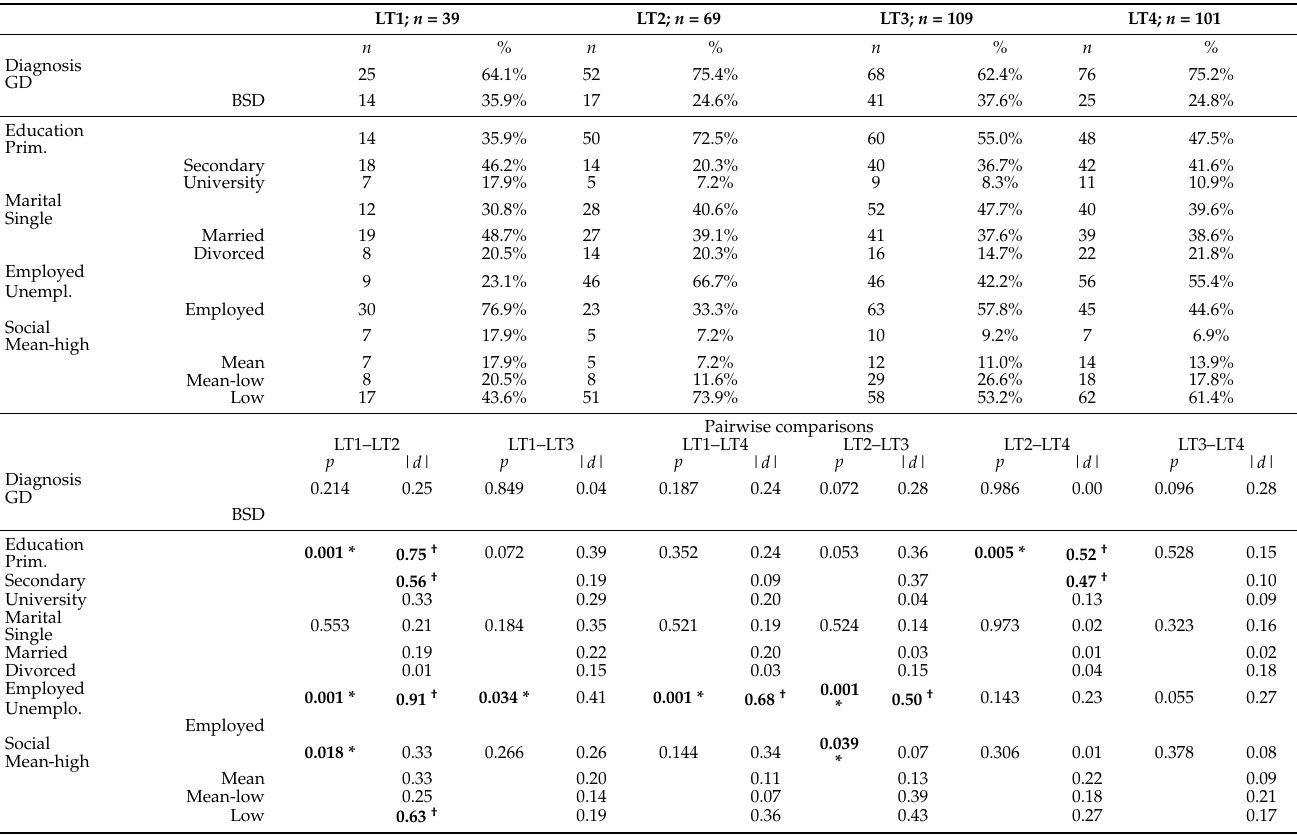
Table 4. Comparison between the latent classes for the diagnosis subtype and the sociodemographics.